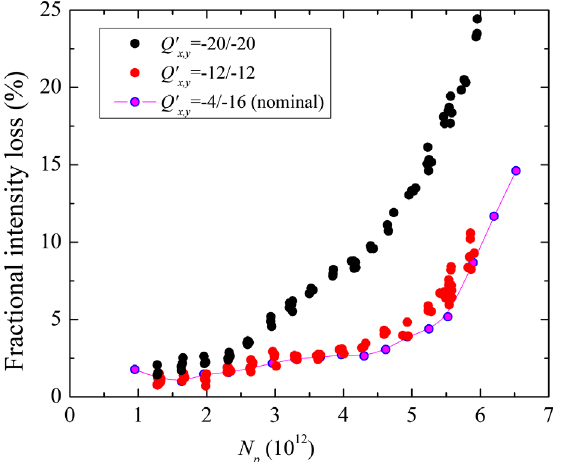
FIG. 7. Transmission efficiency 1 ms after injection for differ- ent chromaticities Q 0 x;y vs N p .